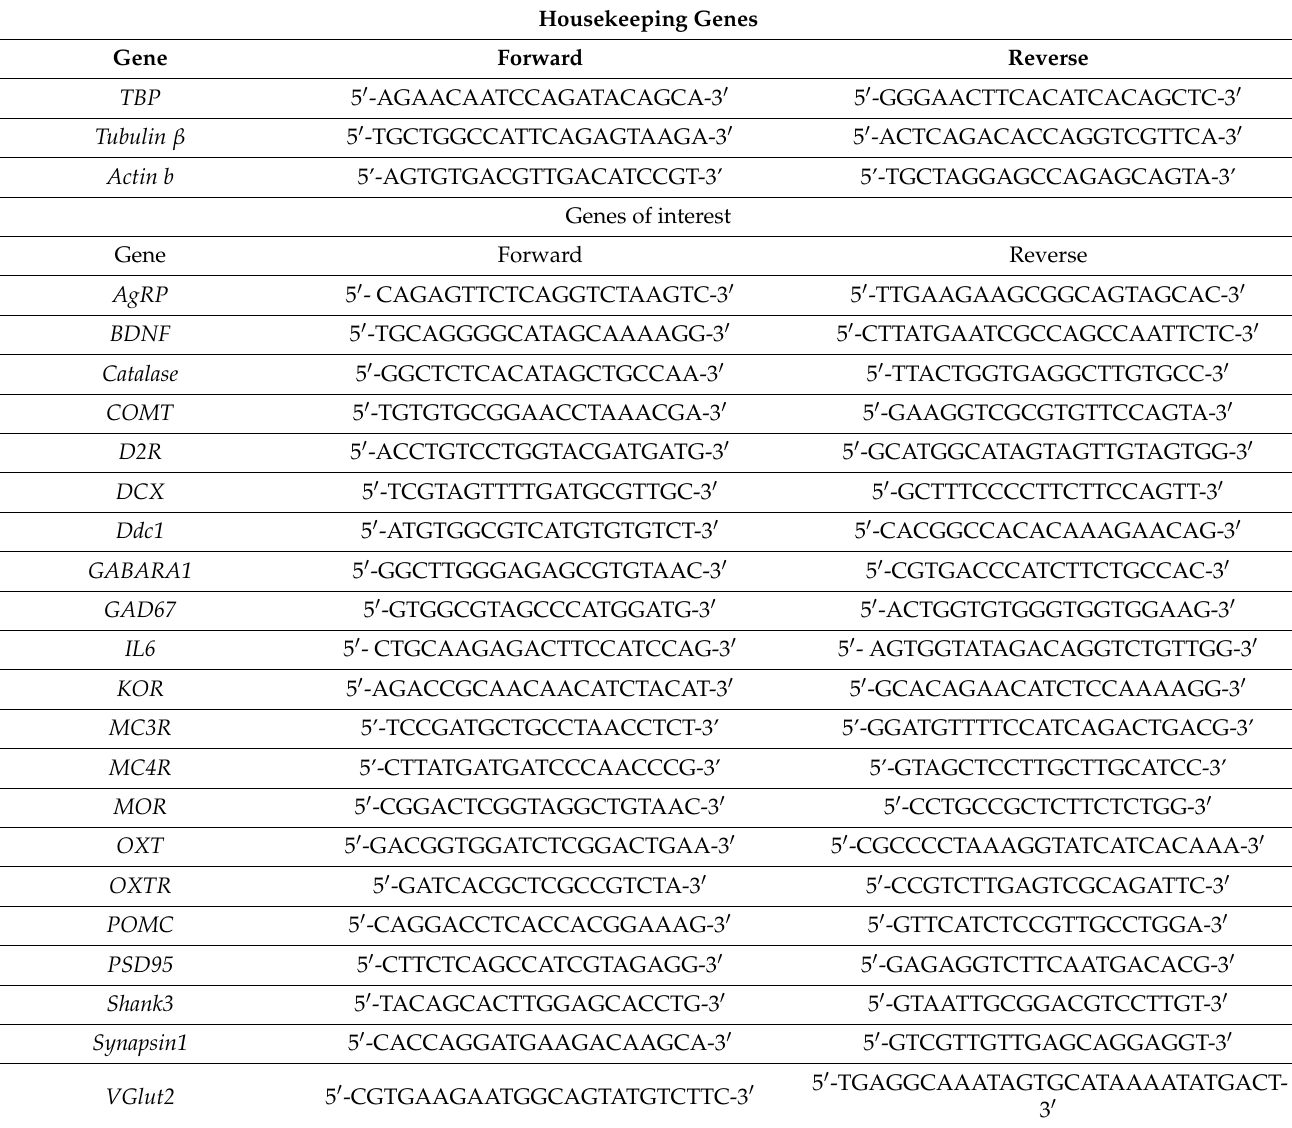
Table 1. List of all primers used in rtPCR